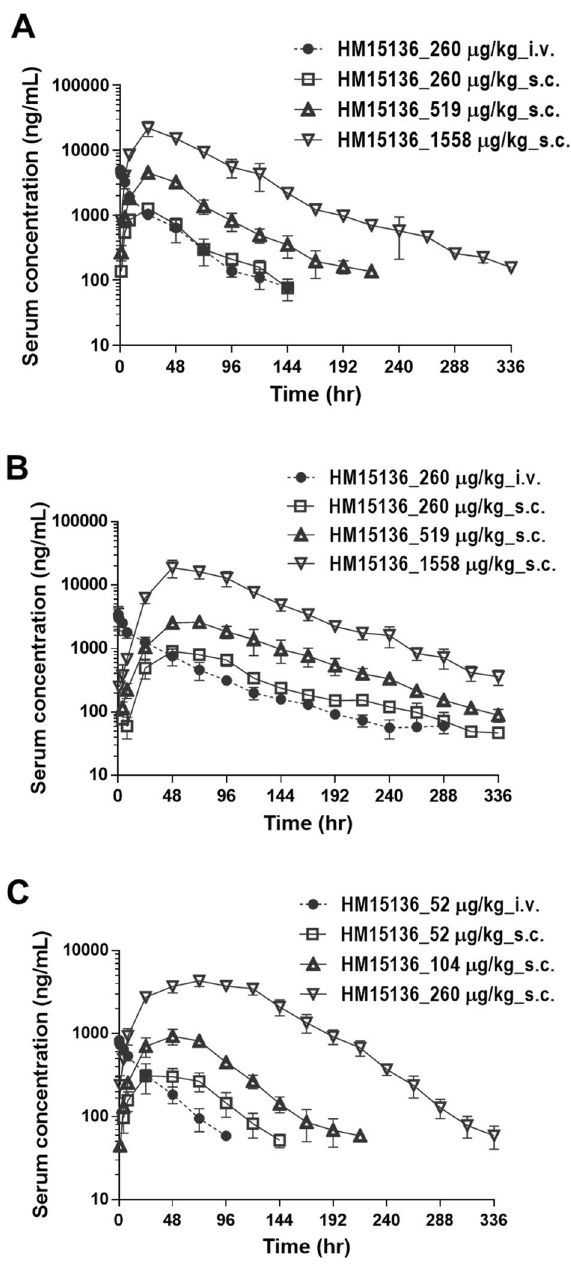
Figure 4. HM15136 exhibited good bioavailability and had high systemic exposure and long-lasting PK properties in mice, rat, and dog. ( A ) A single dose of HM15136 was administered via the intravenous and subcutaneous routes in ICR mice (n = 3/time point/group). The error bars indicate standard deviation. The symbols represent the following: (filled circle) HM15136 (i.v.) 260 μg/kg; (open square) HM15136 (s.c.) 260 μg/ kg; (open triangle) HM15136 (s.c.) 519 μg/kg; (open reverted triangle) HM15136 (s.c.) 1558 μg/kg; ( B ) A single dose of HM15136 was administered via the intravenous and subcutaneous routes in SD rats (n = 3/group). The error bars indicate standard deviation. The symbols represent the following: (filled circle) HM15136 (i.v.) 260 μg/kg; (open square) HM15136 (s.c.) 260 μg/kg; (open triangle) HM15136 (s.c.) 519 μg/kg; (open reverted triangle) HM15136 (s.c.) 1558 μg/kg. ( C ) A single dose of HM15136 was administered via the intravenous and subcutaneous routes in beagle dogs (n = 3/group). The error bars indicate standard deviation. The symbols represent the following: (filled circle) HM15136 (i.v.) 52 μg/kg; (open square) HM15136 (s.c.) 52 μg/kg; (open triangle) HM15136 (s.c.) 104 μg/kg; (open reverted triangle) HM15136 (s.c.) 260